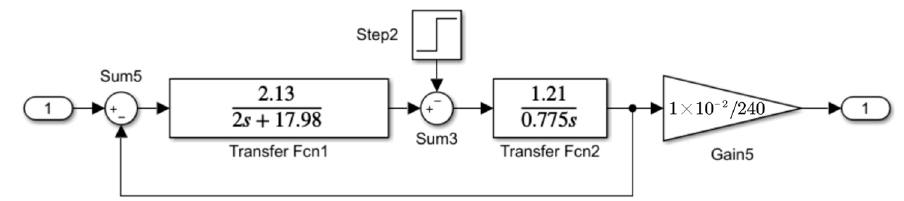
Figure 11. Electric actuator simulation model.